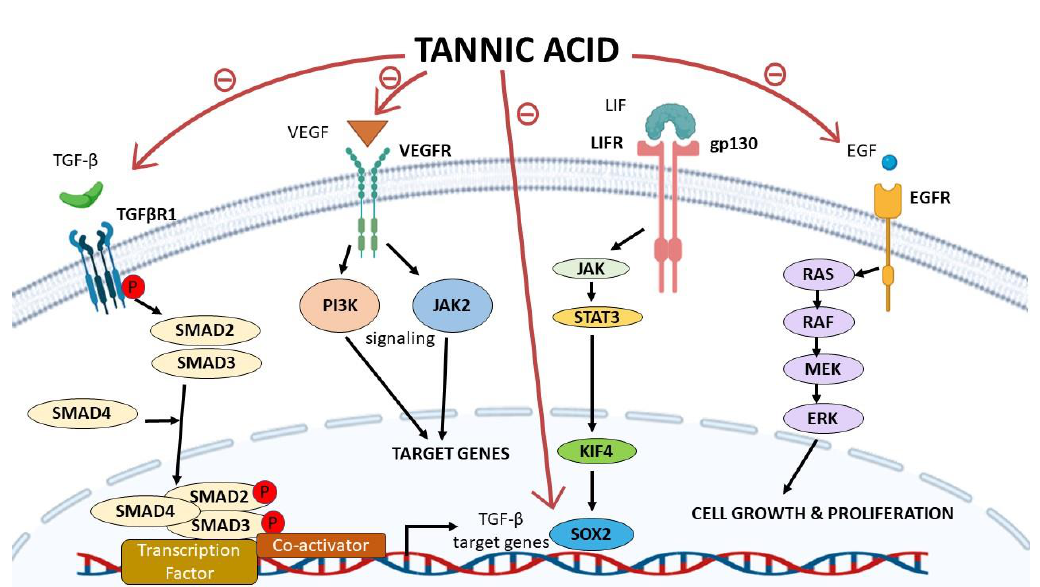
Figure 1. Tannic acid (TA) acts as a repressor for multiple proteins essential in several oncological signaling pathways. TA inhibits SMAD-dependent gene transcription in response to TGF-β, therefore inhibiting the transcription of TGF-β target genes. TA also inhibits VEGF/VEGFR, inhibiting a major angiogenesis signaling pathway in cancer. Moreover, TA inhibits the expression of SOX2 gene and inhibits EGF/EGFR signaling pathway and consequently cell growth and proliferation.